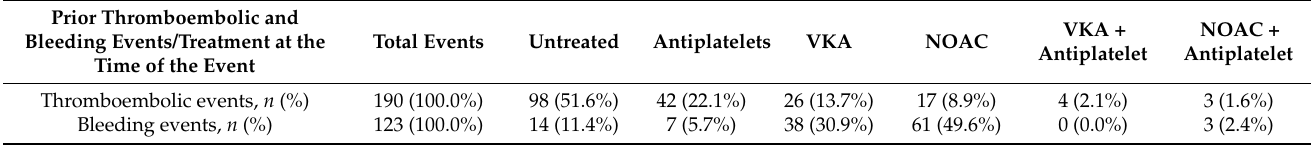
Table 3. Distribution of previous thromboembolic and bleeding events by ongoing treatment at the time of the